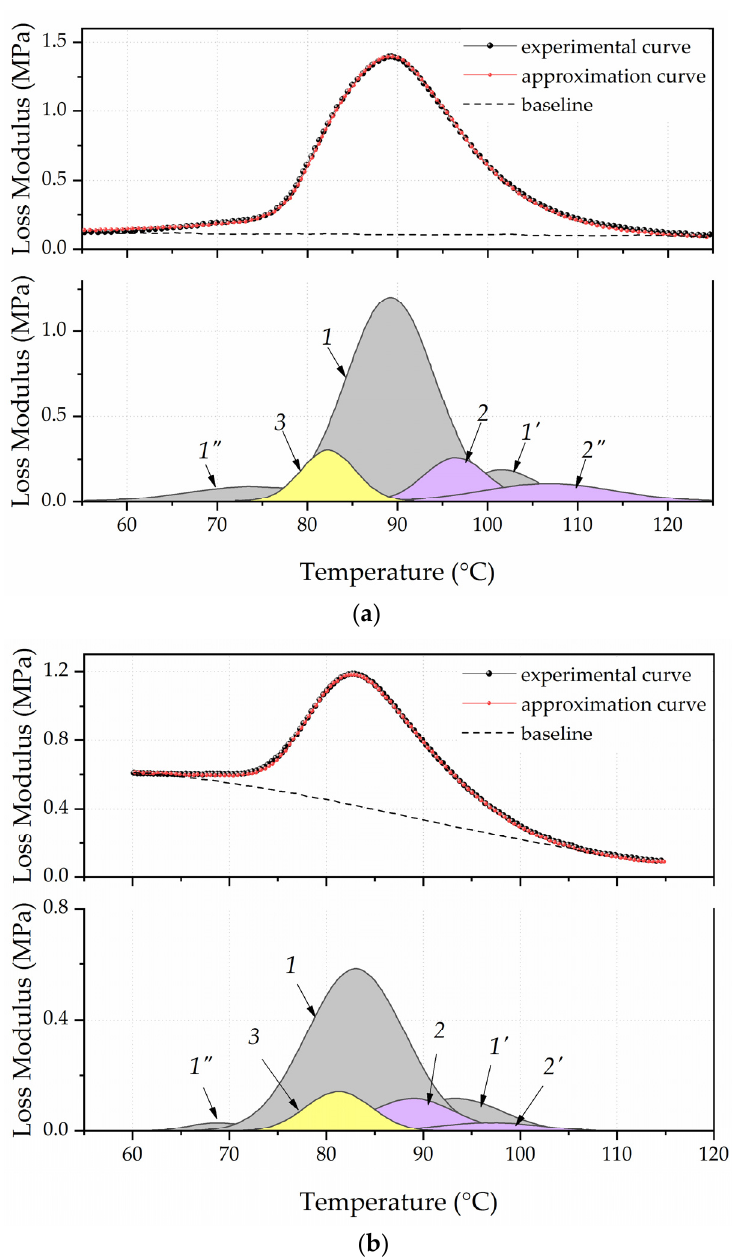
Figure 4. Approximation of the experimental peak of the unfilled polyurethane’s mechanical loss modulus.